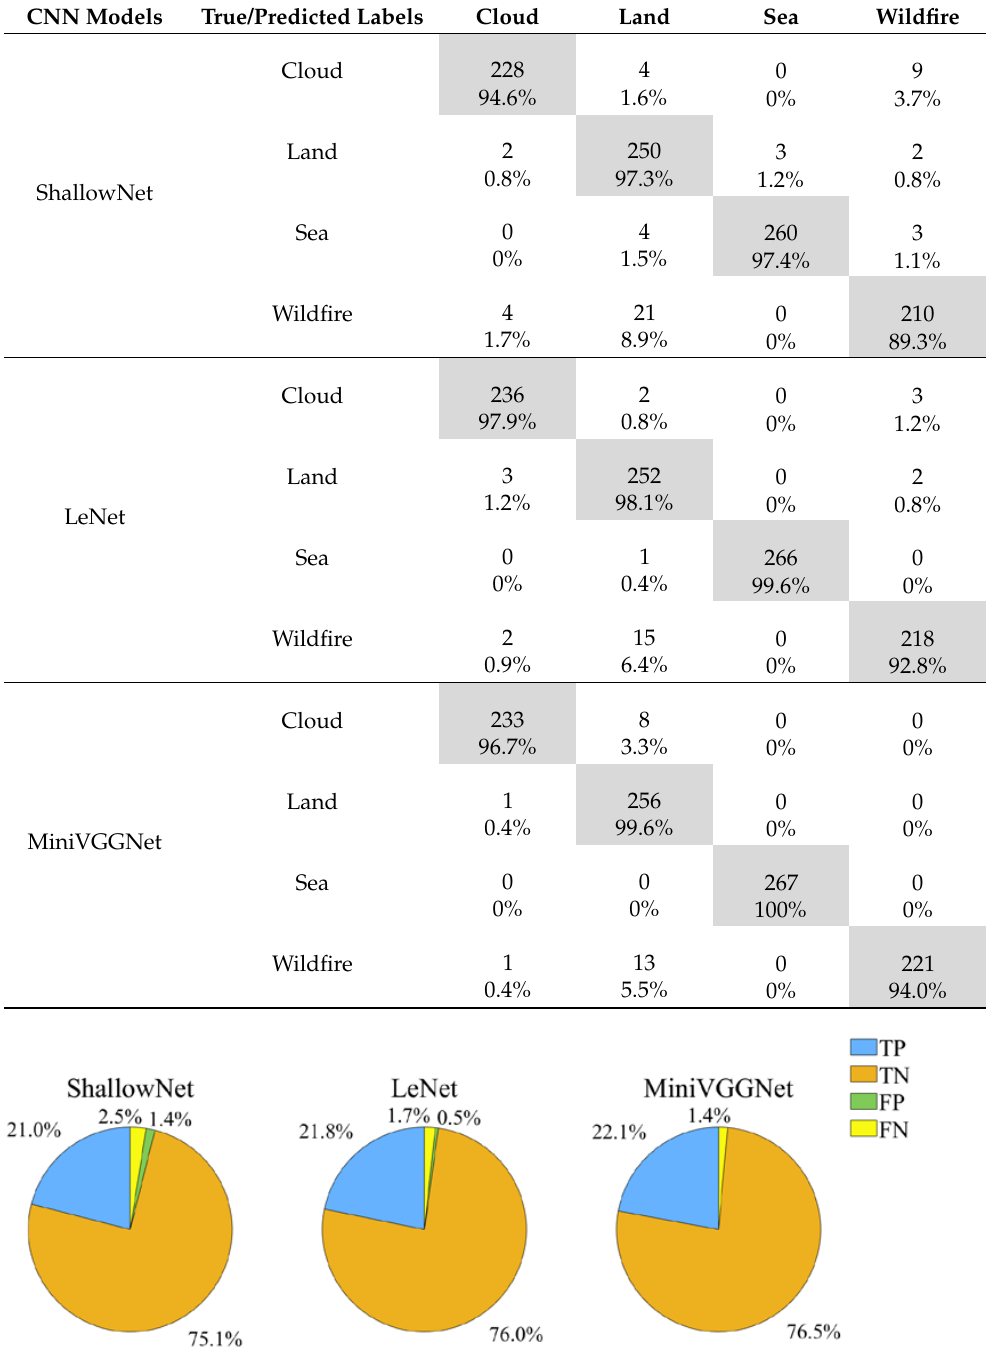
Figure 10. The true positive, true negative, false positive, and false negative results corresponding to the models.